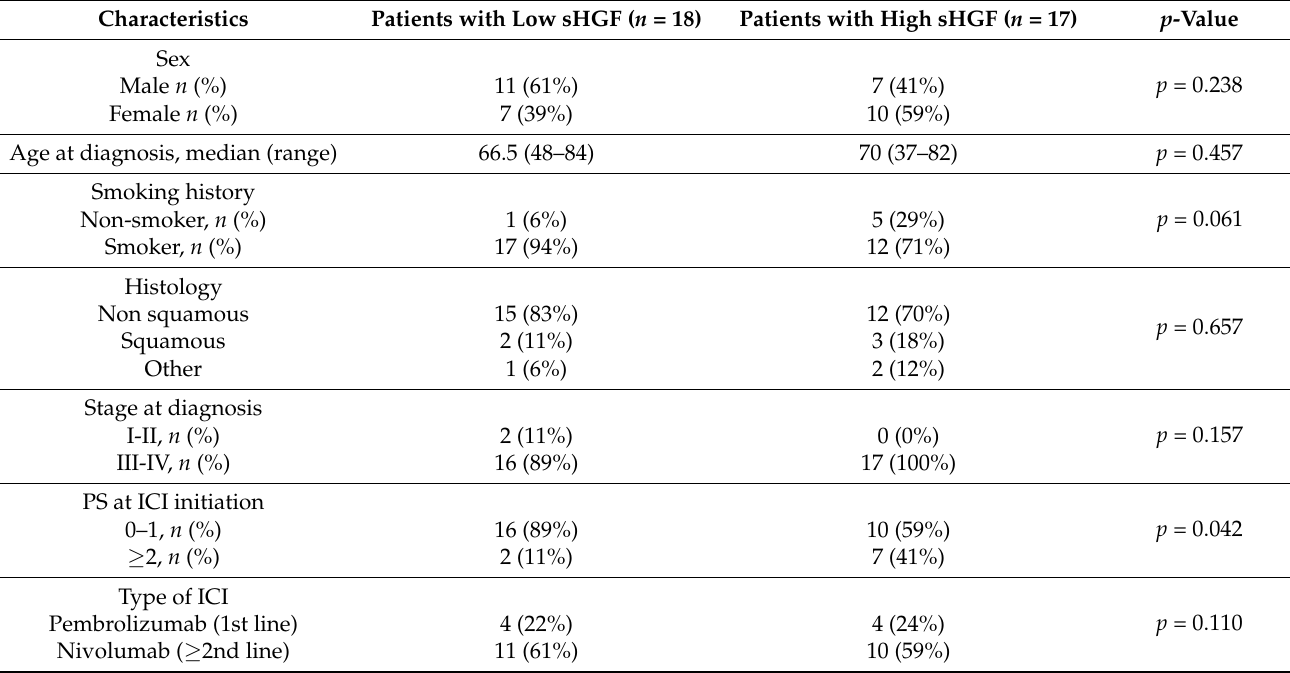
Table 2. Characteristics of patients with high and low pre-ICI sHGF